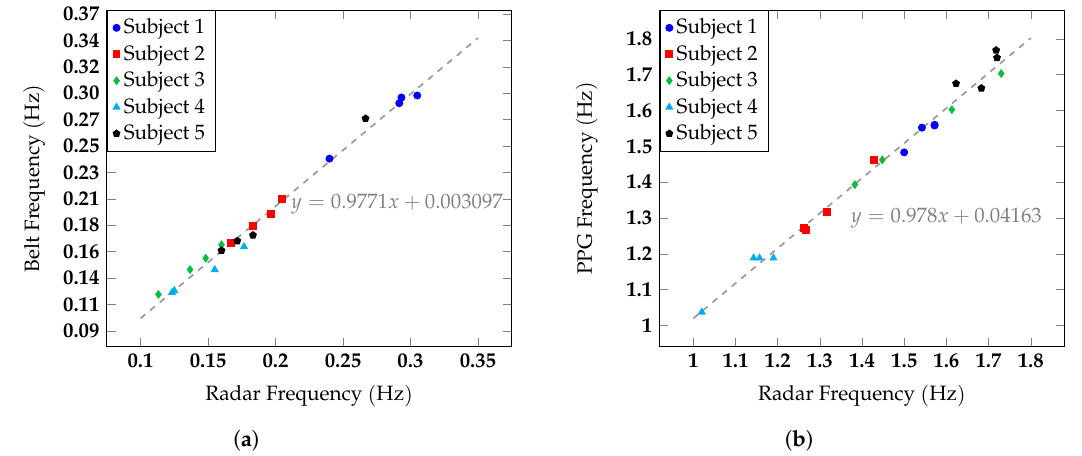
Figure 12. Regression of ( a ) the respiratory rate measured with the respiratory belt and the radar and ( b ) the heart rate measured with the PPG and the radar.